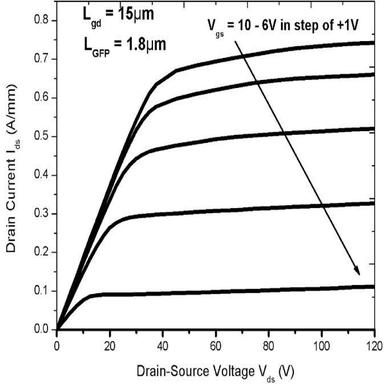
Variation of Ids-Vds characteristics measured with Lgd = 15 μm, LGFP = 1.8 μm and Vgs stepping between 6 and 10 V with increment of +1 V for HfAl2O3 Quaternary Barrier QB-MIS-HEMT.